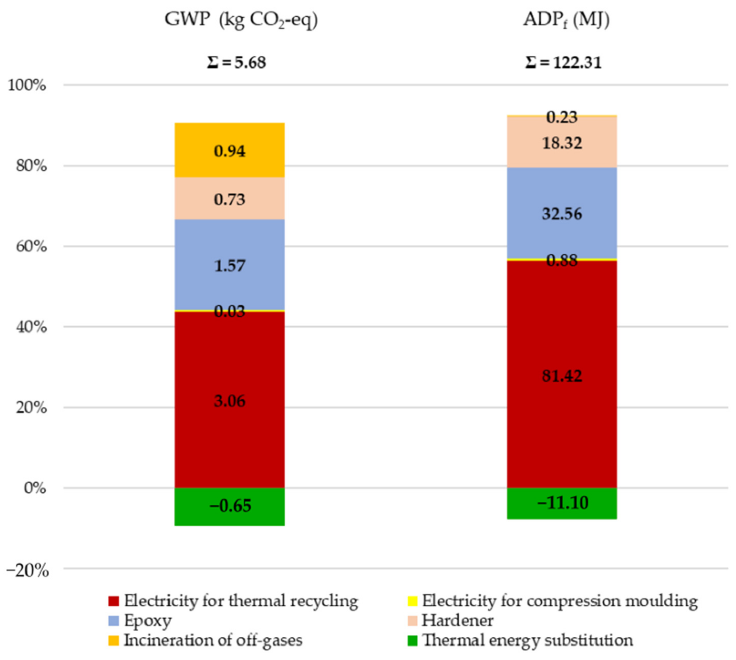
Figure 4. GWP and ADP f results for producing 1 kg of rCFRP